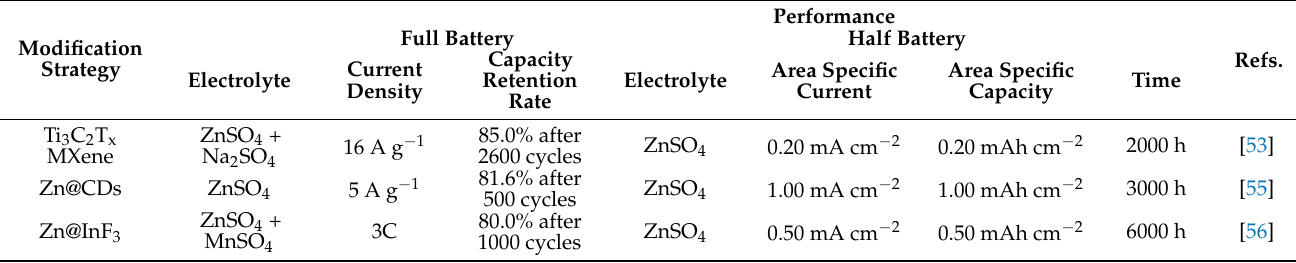
Table 1. Performance of AZIBs with a modified zinc anode